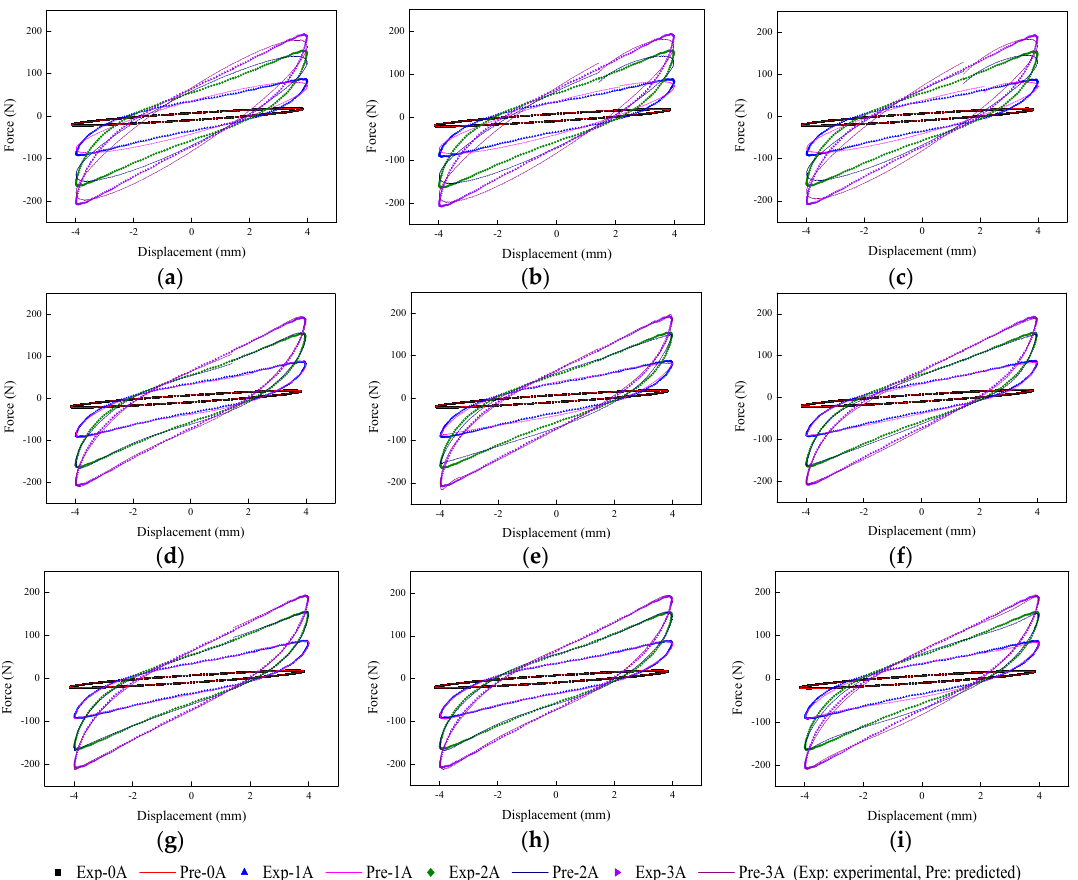
Figure 19. Comparisons of force–displacement responses between experimental results and model predictions when the loading frequency and amplitude are 1 Hz and 4 mm. ( a ) Kelvin–Voigt model, ( b ) four-parameter viscoelastic model, ( c ) rheological model, ( d ) BW model, ( e ) improved BW model, ( f ) Dahl model, ( g ) improved LuGre friction model, ( h ) strain stiffening model, and ( i ) hyperbolic hysteresis model.